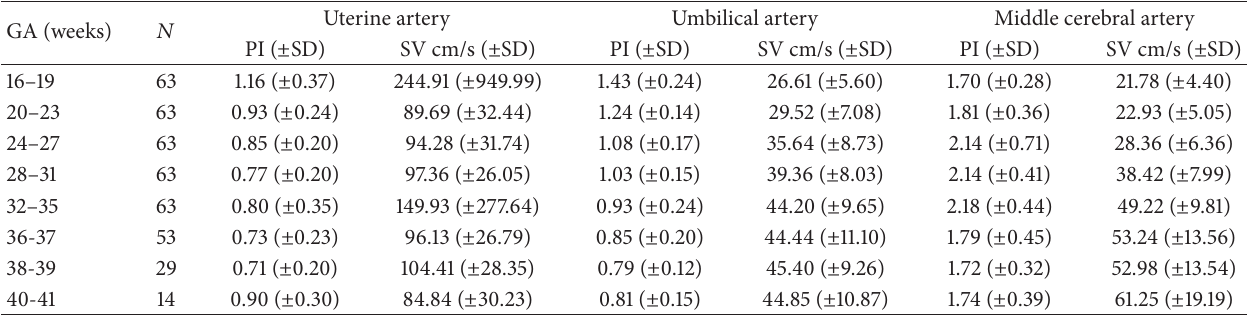
Table 2: Means and standard deviation (SD) of PI and SV of uterine, umbilical, and middle cerebral artery in cohort of a low risk pregnant women.